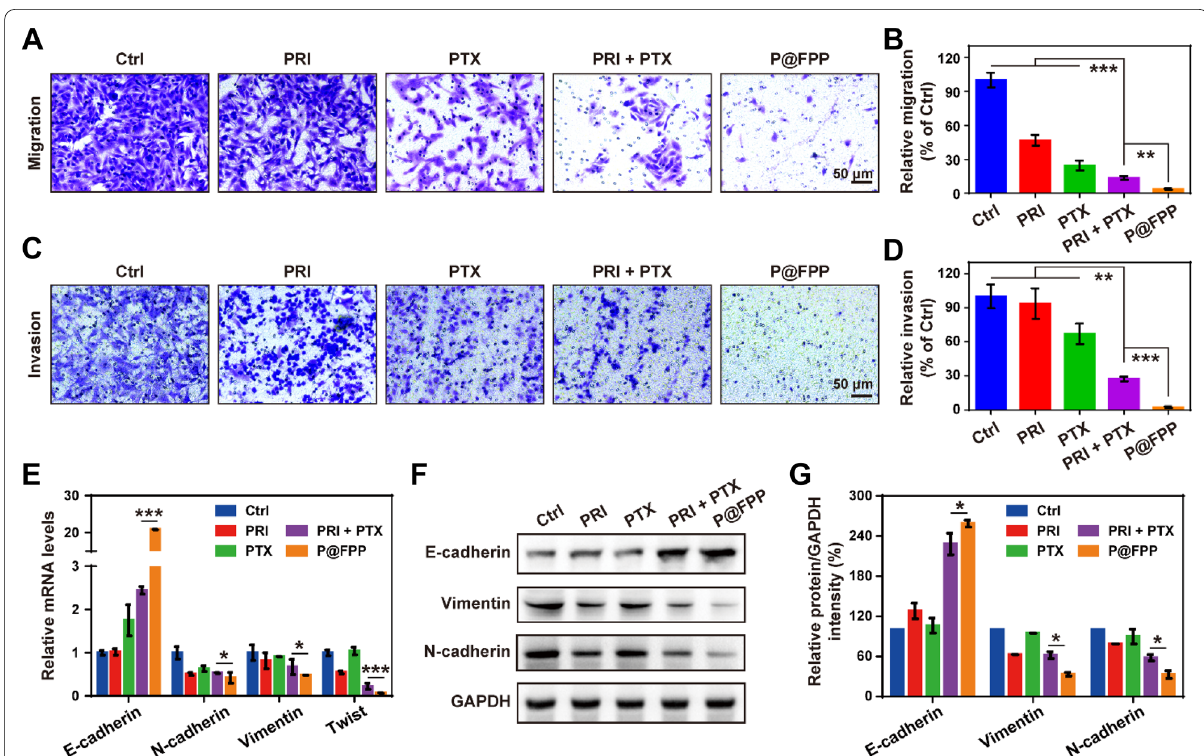
Fig. 6 Cell migration and invasion inhibition of P@FPP NMs in vitro. A–B Representative cell migration images and corresponding quantitative analysis of A549 cells treatment of PBS, PRI, PTX, PRI PTX, and F@FPP NMs using Transwell assay (n 3). C–D Cell invasion analysis of tumor cells + = with different formulations (n 3). E The mRNA levels of epithelial-mesenchymal transition (EMT) related genes (E-cadherin, N-cadherin, Vimentin, = and Twist) in A549 cells with different formulations by using qRT-PCR analysis (n 3). F–G Western blot and relative quantitative analysis of = E-cadherin, N-cadherin, and Vimentin expression in 549 cells after different treatments (n 3). *: P < 0.05. **: P < 0.01. ***: P < =